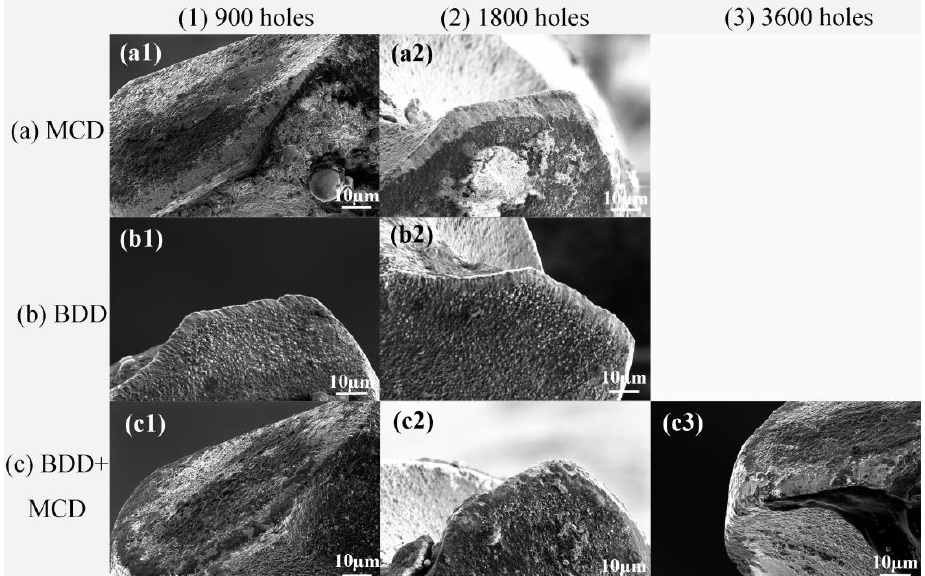
Figure 6. Images of main cutting edges for ( a1 , a2 ) MCD; ( b1 , b2 ) BDD; and ( c1 – c3 ) BDD + MCD coated micro drills after drilling ( a1 , b1 , c1 ) 900; ( a2 , b2 , c2 ) 1800; and ( c3 ) 3600